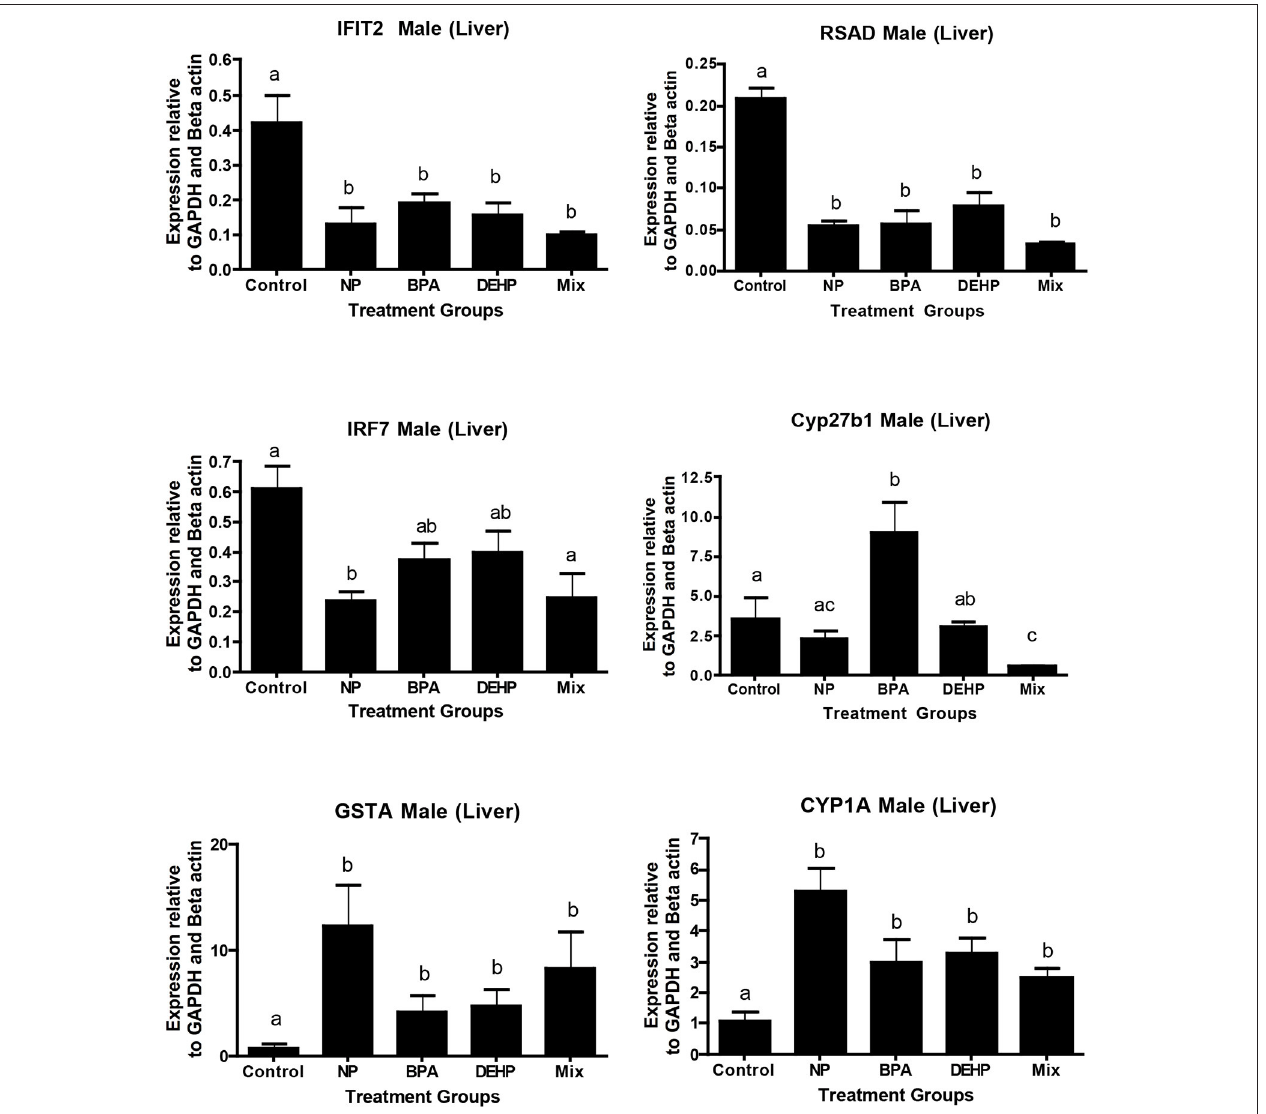
FIGURE 6 | Validation of microarray results by quantitative real-time PCR (qPCR). Effects of 100 µ g/L of NP, BPA, DEHP and the mixture of three chemicals on genes involved in the immune response and detoxification following 21 days exposure. The expression levels were measured using qPCR and normalized against the mean of GAPDH and β -actin (mean ± SEM). Different letters indicate a significant difference (ANOVA followed by Tukey Test, P < 0.05, n =